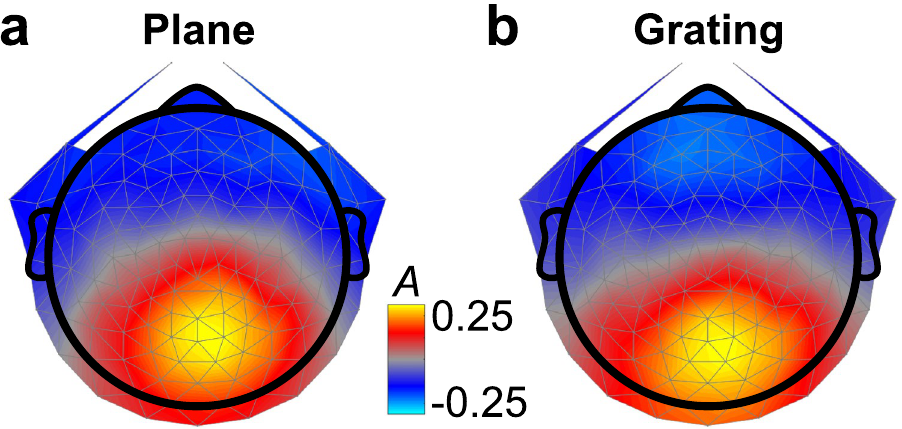
Figure 2. Topographies of the first reliable component for responses to plane and grating stimuli (N = 20). Units of the forward model (A) were maximal over midline occipital electrodes, indicating that neurons in early visual cortex were responding systematically across trials. Small differences between the plane ( a ) and the grating ( b ) responses include that the grating response is shifted more towards posterior electrodes and is